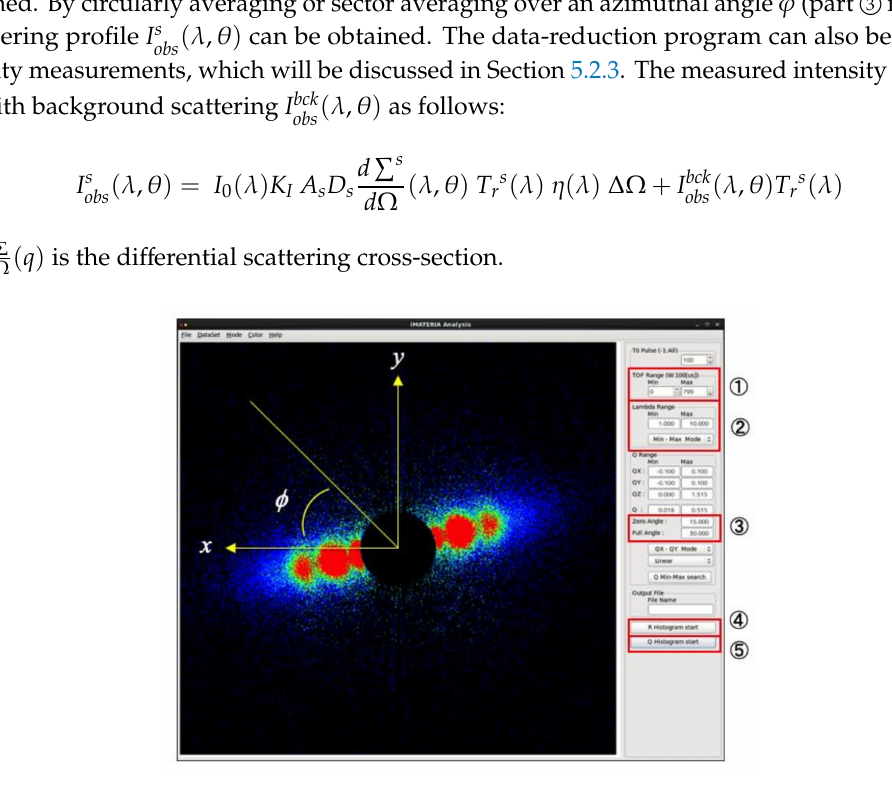
Figure 6. User interface of data reduction program for iMATERIA, showing small-angle neutron scattering (SANS) obtained for a lamellar block copolymer